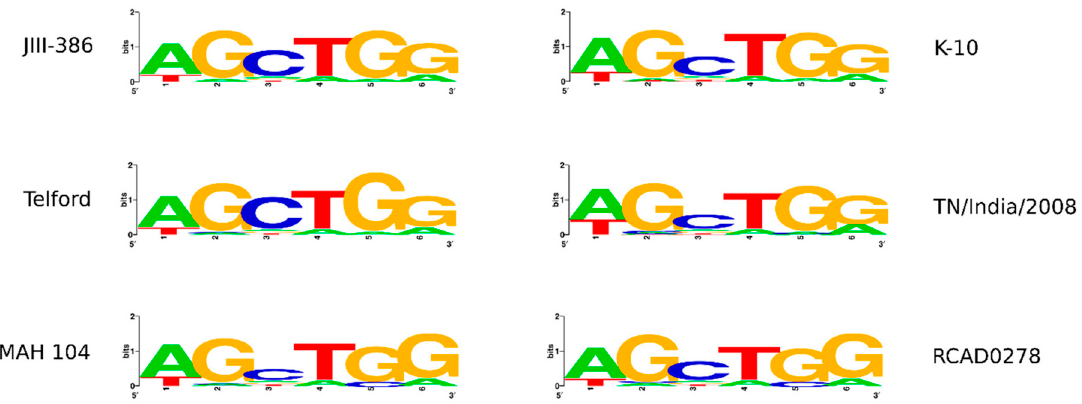
Figure 2. Shine–Dalgarno sequence motifs of six investigated M. avium